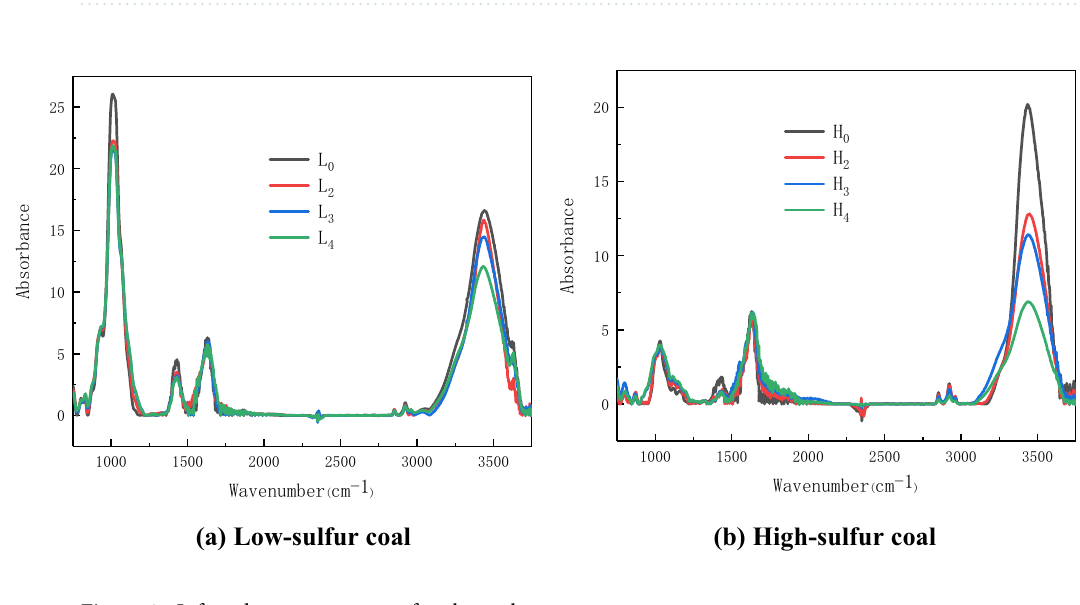
Figure 4. Infrared spectrum curve of coal